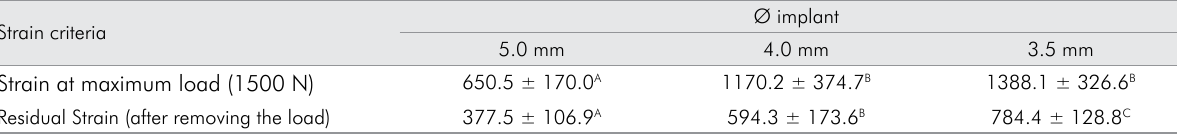
Table 2. The mean strain values (µS) ± SDs and statistical categories defined via Tukey’s test (n = 10) for the three different implant diameters.